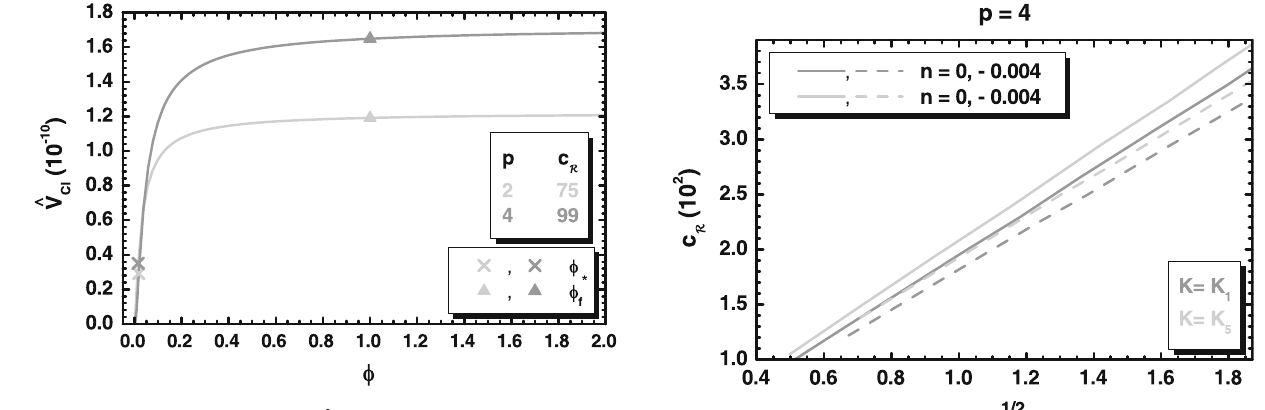
Fig. 2 The inflationary potential (cid:2) V CI as a function of φ for K = K 1 , φ (cid:21) = 1 , n = 0 and p = 2 (light gray line) or p = 4 (gray line). The values corresponding to φ (cid:21) , φ f are also indicated Fig. 3 Allowed values of c R versus